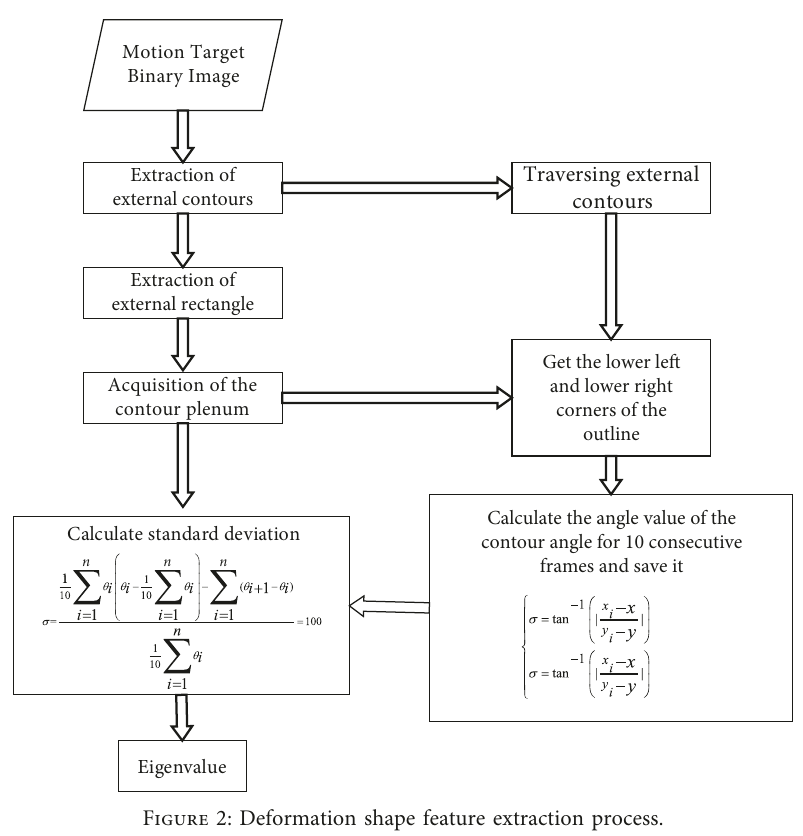
Figure 2: Deformation shape feature extraction process.